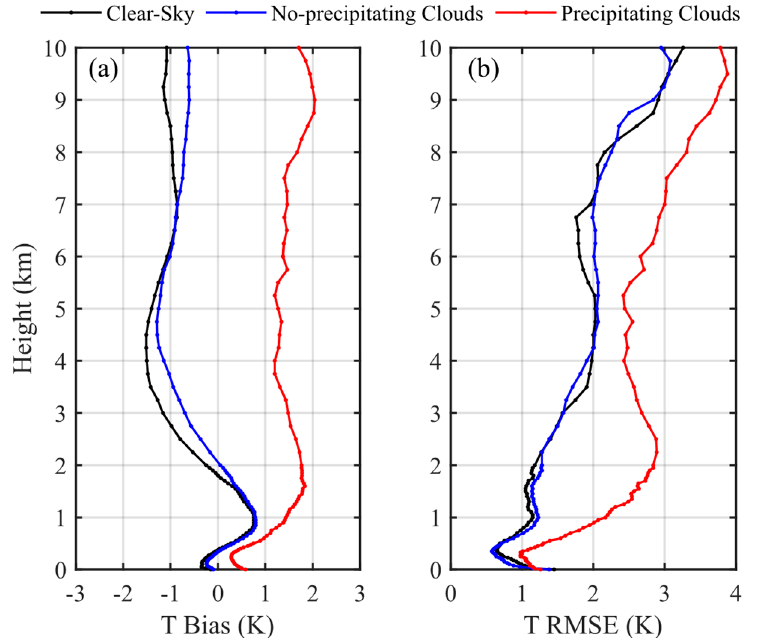
Figure 8. Variation diagrams of temperature profile Bias ( a ) and RMSE ( b ) with height for conditions of clear-sky (black), no-precipitating cloud (blue) and precipitating cloud (red).